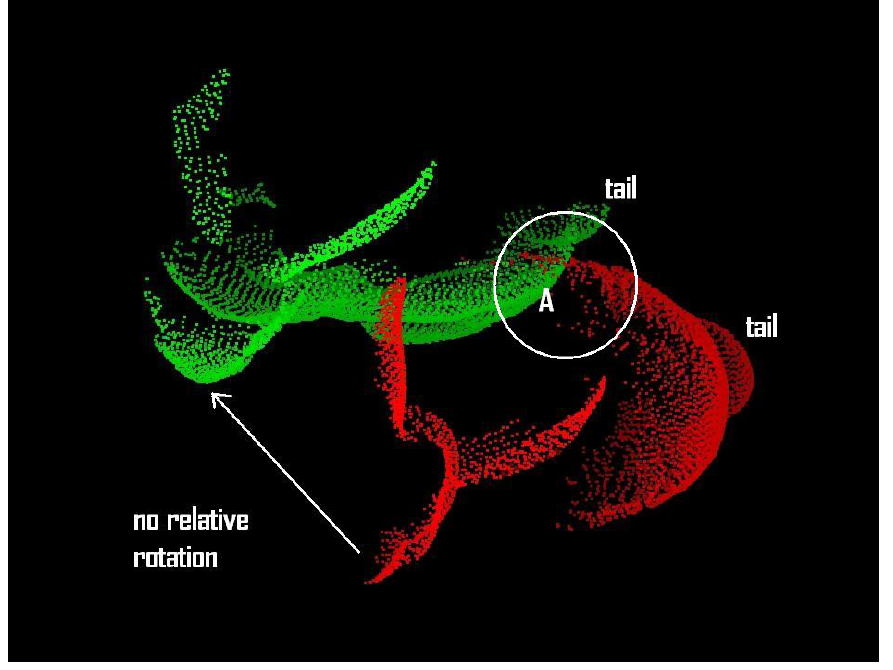
Figure 10. Bunny000 and bunny090 translated to translation 1 with zero relative rotation. There is no relative rotation and the relative translation is (H/4, L/4, W/2) where H, L, and W are the height, length, and width of the object, i.e. the Stanford